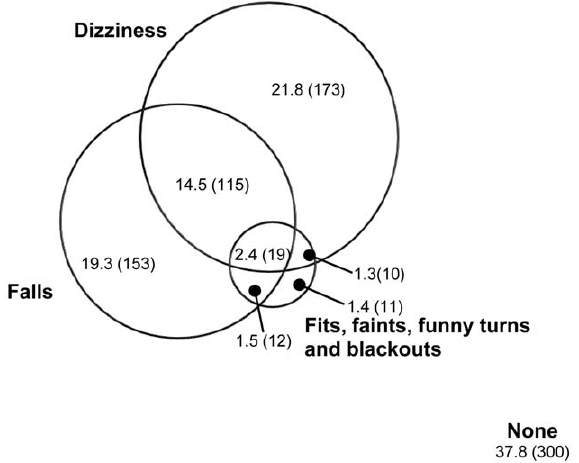
Figure 3. Venn diagram showing the overlap between falls, dizziness and blackouts, % (n) 2 . Figure footnote: 2 Reported for n=793 with no missing data in any category.